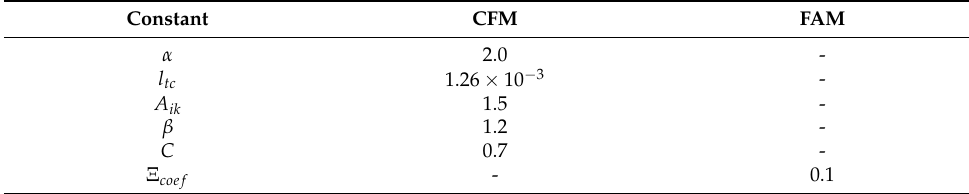
Table 2. Model constants used in this work.